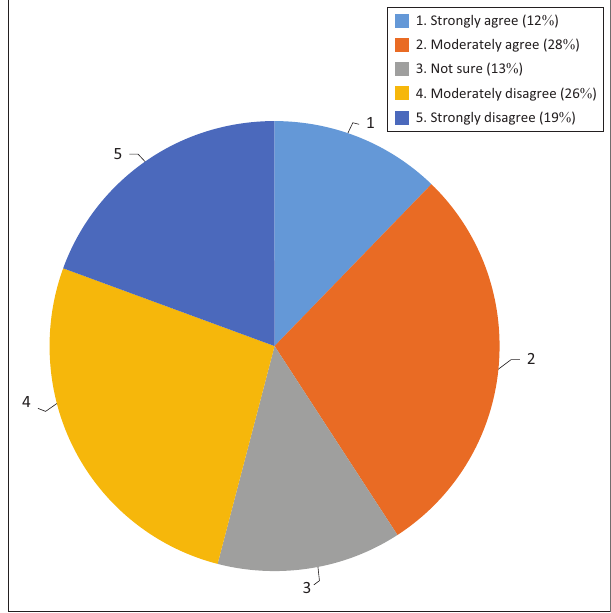
FIGURE 3 : Availability of institutional capacity to implement adaptation